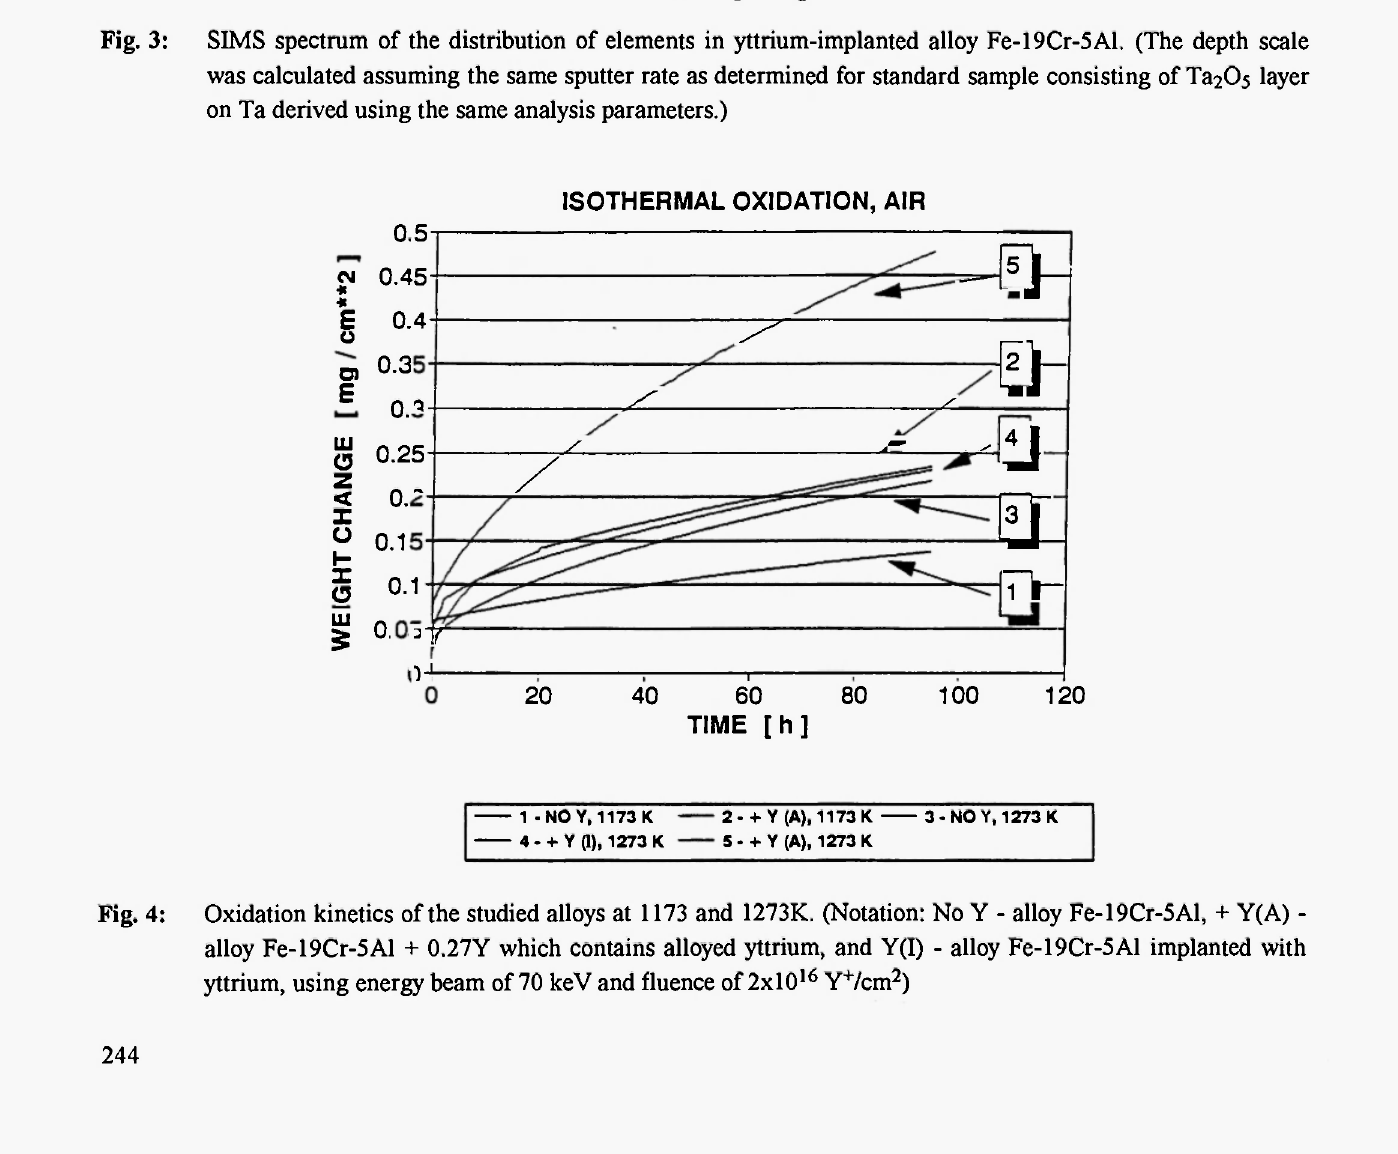
Fig. 4: Oxidation kinetics of the studied alloys at 1173 and 1273K. (Notation: No Y - alloy Fe-19Cr-5Al, + Y(A) - alloy Fe-19Cr-5Al + 0.27Y which contains alloyed yttrium, and Y(I) - alloy Fe-19Cr-5Al implanted with yttrium, using energy beam of 70 keV and fluence of 2x10 16 Y + /cm 2 )